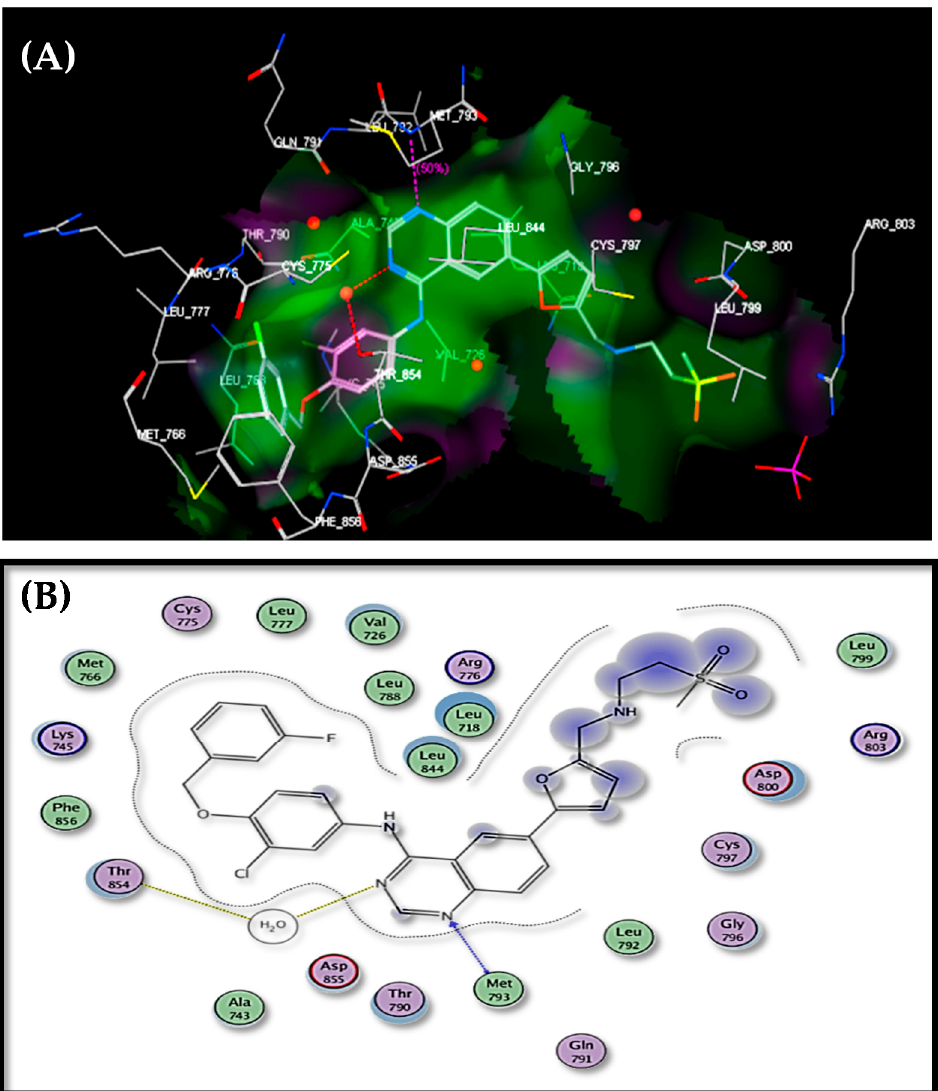
Figure 5. Docking of lapatinib within the ATP binding site of EGFR: ( A ) 3D binding mode; ( B ) 2D binding mode.